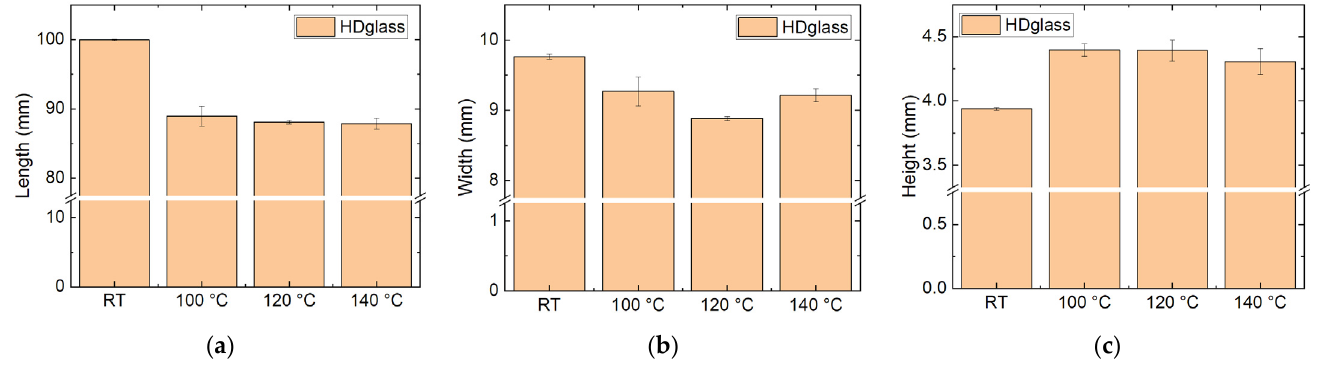
Figure 6. Dimensions of HDglass samples, as printed (“RT”, room temperature) and heat-treated at different temperatures: ( a ) length; ( b ) width; ( c ) height. different temperatures: ( a ) length; ( b ) width; ( c ) height.